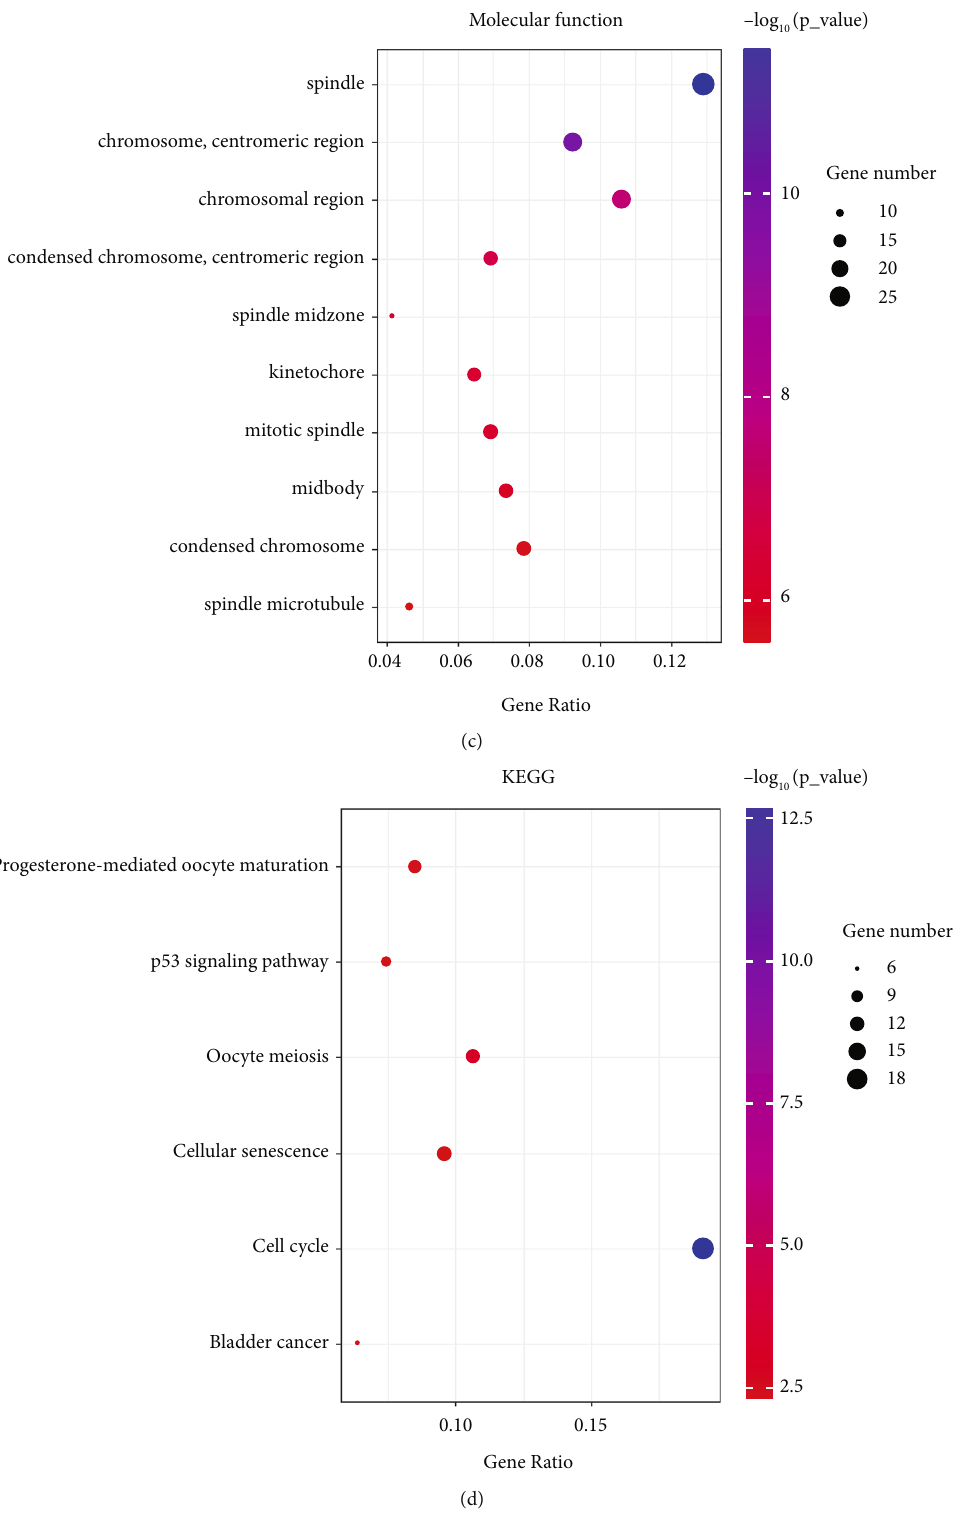
Figure 3: GO and KEGG enrichment analyses of DEGs among GSE33294, GSE104310, and GSE144269. (a) GO: biological process enrichment analysis of DEGs among GSE33294, GSE104310, and GSE144269. (b) GO: cellular component enrichment analysis of DEGs among GSE33294, GSE104310, and GSE144269. (c) GO: molecular function enrichment analysis of DEGs among GSE33294, GSE104310, and GSE144269. (d) KEGG pathway enrichment analysis of DEGs among GSE33294, GSE104310, and